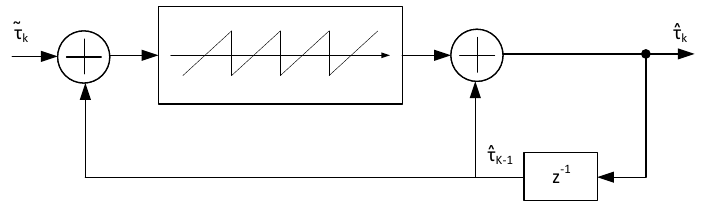
Figure 21. Timing estimates unwrapping